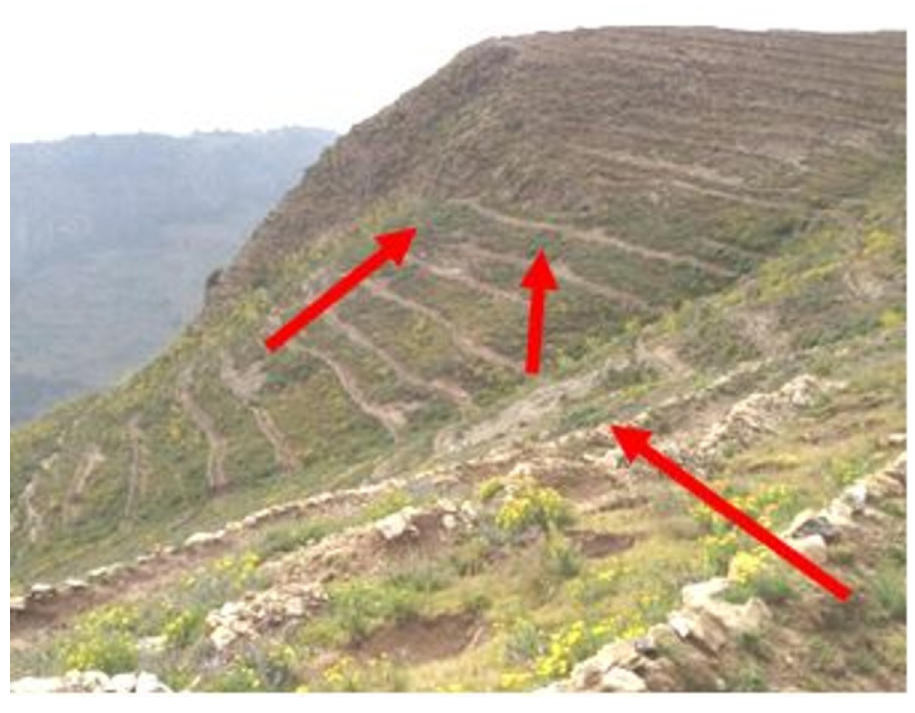
Fig 5. Hillside terraces.